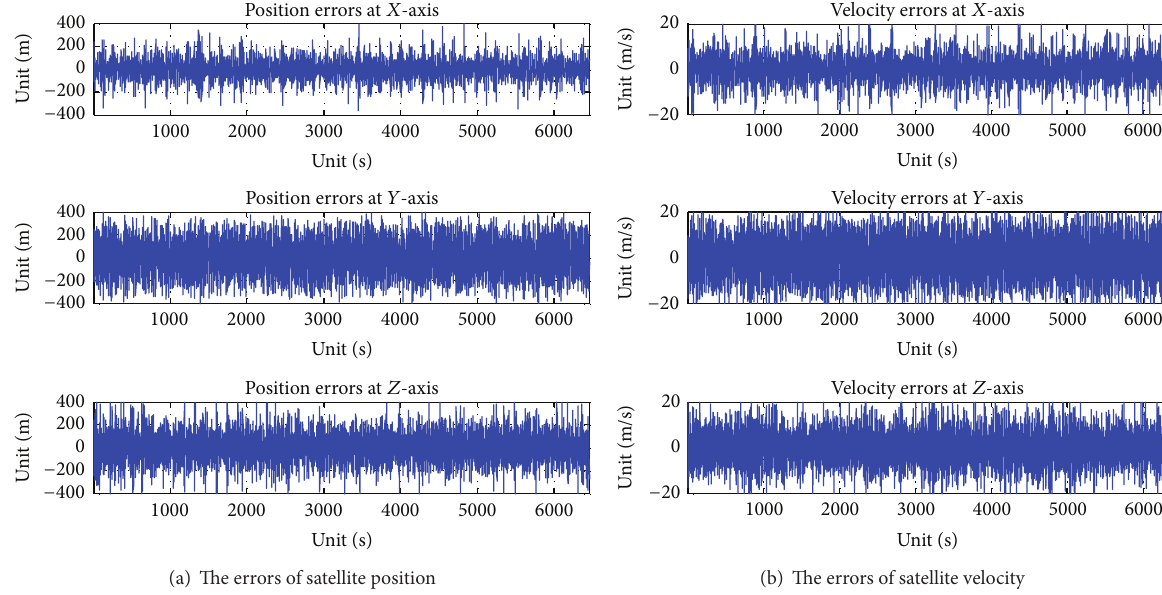
Figure 8: The autonomous result with a sensor that integrated ultraviolet earth sensor and star